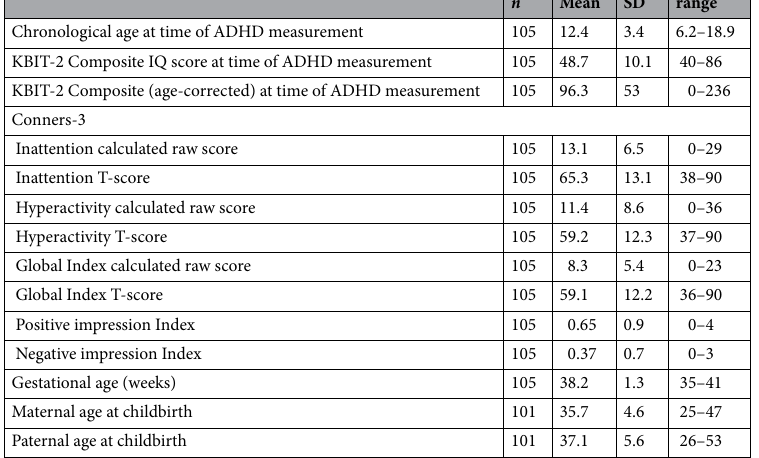
Table 2. Descriptive Statistics of variables of interest.